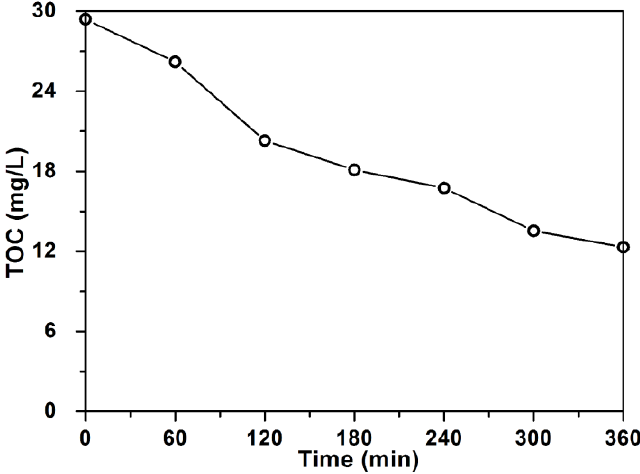
Figure 8. Total organic carbon (TOC) removal during RhB degradation (40 mg·L −1 , 100 mL) over 3%M-Bi (100 mg) under visible light (λ > 400 nm).